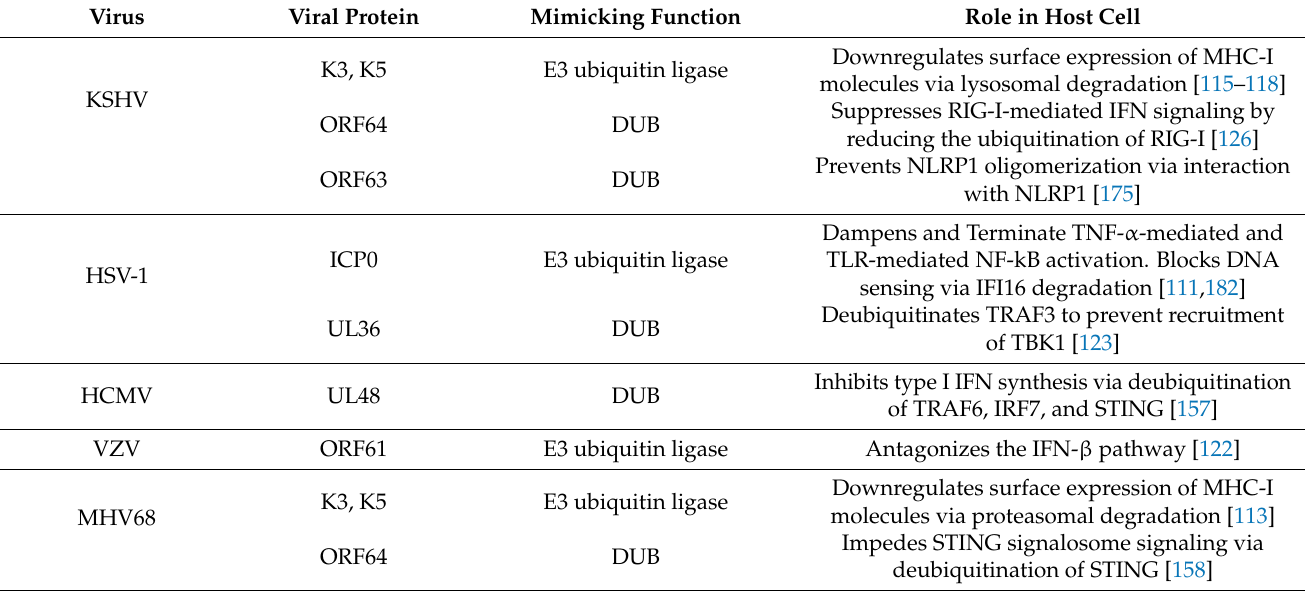
Table 1. Herpesviral proteins mimicking E3 ubiquitin ligase or deubiquitinase. Virus Viral Protein Mimicking